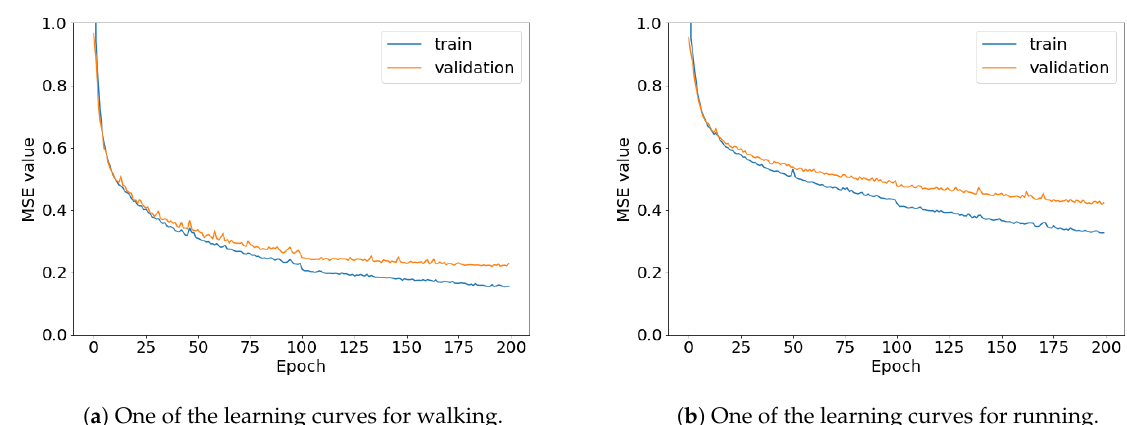
( a ) One of the learning curves for walking. ( b ) One of the learning curves for running. Figure 15. Some of the learning curves of the trained CNN model for ( a ) walking and ( b ) running.